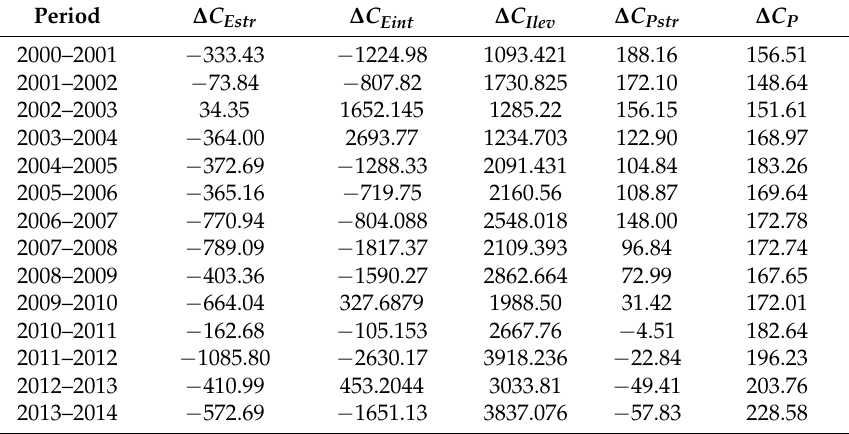
Table 1. Complete decomposition of changes in the household CO 2 emissions of China. (Mt-CO 2